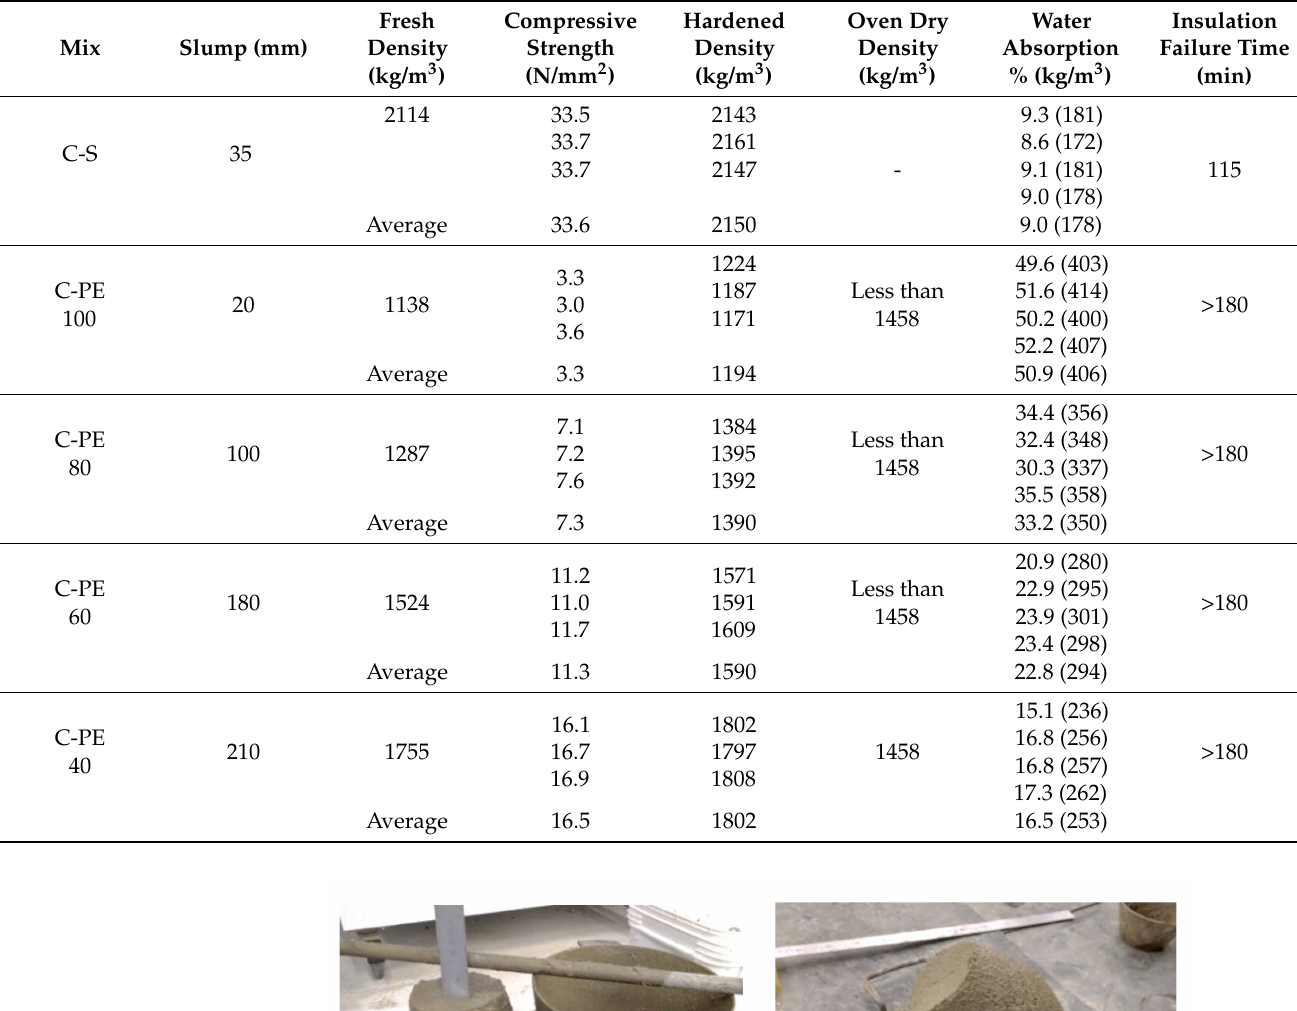
Table 4. Fresh and hardened properties of C-S and C-PE mixes.